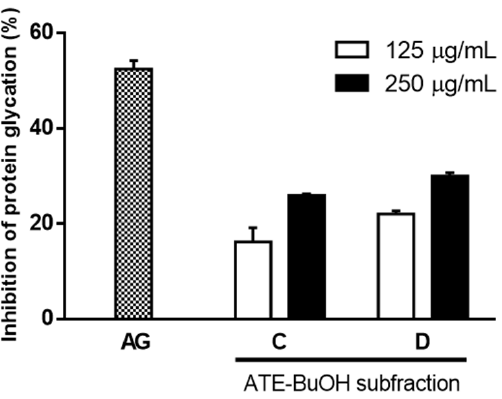
Figure 5. Effects of ATE-BuOH subfractions C and D on MGO-mediated development of fluorescence of AGEs (BSA-MGO assay). Results are means ± SD for n = 3. AG, aminoguanidine. C, the subfraction C of ATE-BuOH. D, the subfraction D of ATE-BuOH.